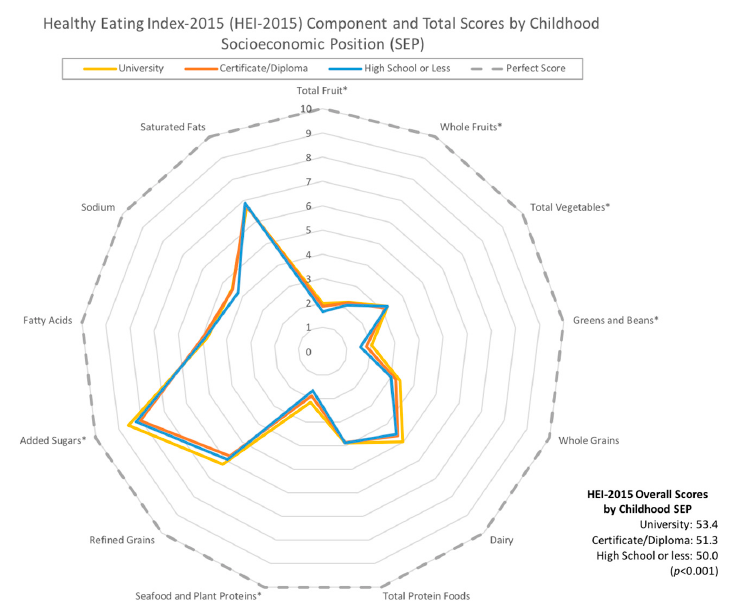
Figure 2. Radar graph depicting component scores across educational levels of childhood socioeconomic position (SEP). Asterisks (*) beside component names indicate that the differences in mean Healthy Eating Index–2015 (HEI-2015) component scores across groups were statistically significant using an analysis of variance (ANOVA) model.